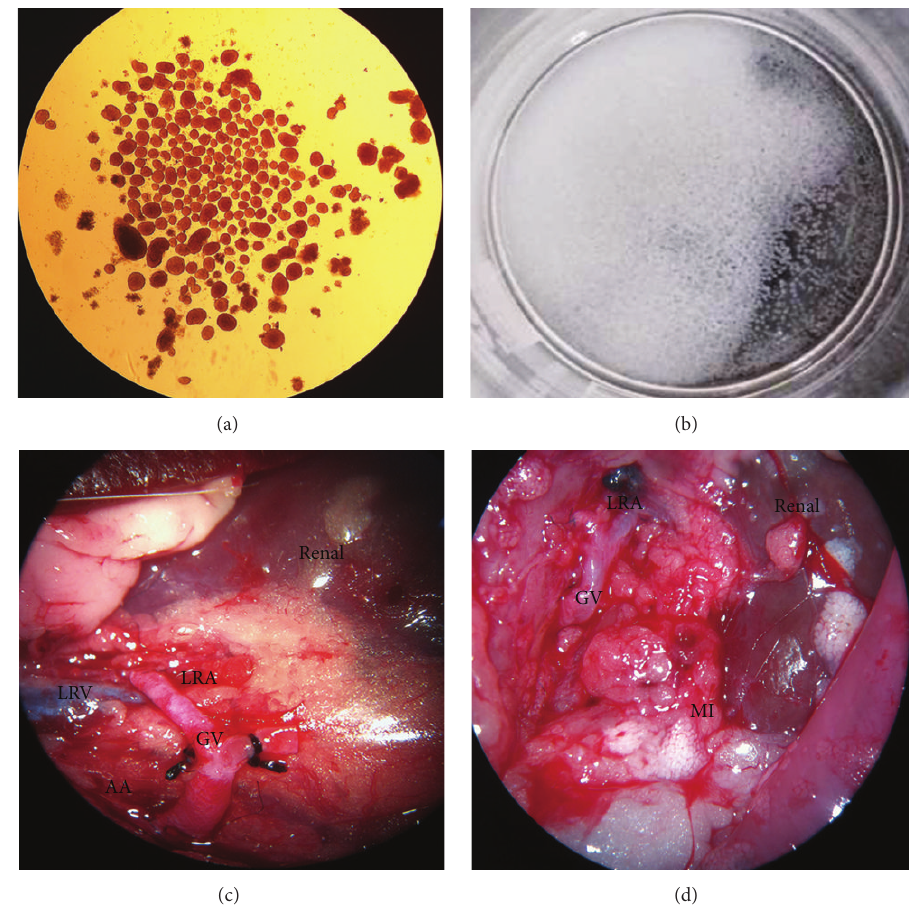
Figure 1: Microencapsulated islet transplantation and revascularization of aortorenal bypass. (a) Isolated and purified islets ( × 40). (b) Microencapsulation of islets. (c) Vascular reconstruction between left renal artery and abdominal aorta. (d) The vascular graft had blood flow, and microcapsules were distributed in the abdominal cavity and wall in the Com group (4 weeks after transplantation). LRA, left renal artery; LRV, left renal vein; GV, graft vessel; AA, abdominal aorta; MI, microencapsulated